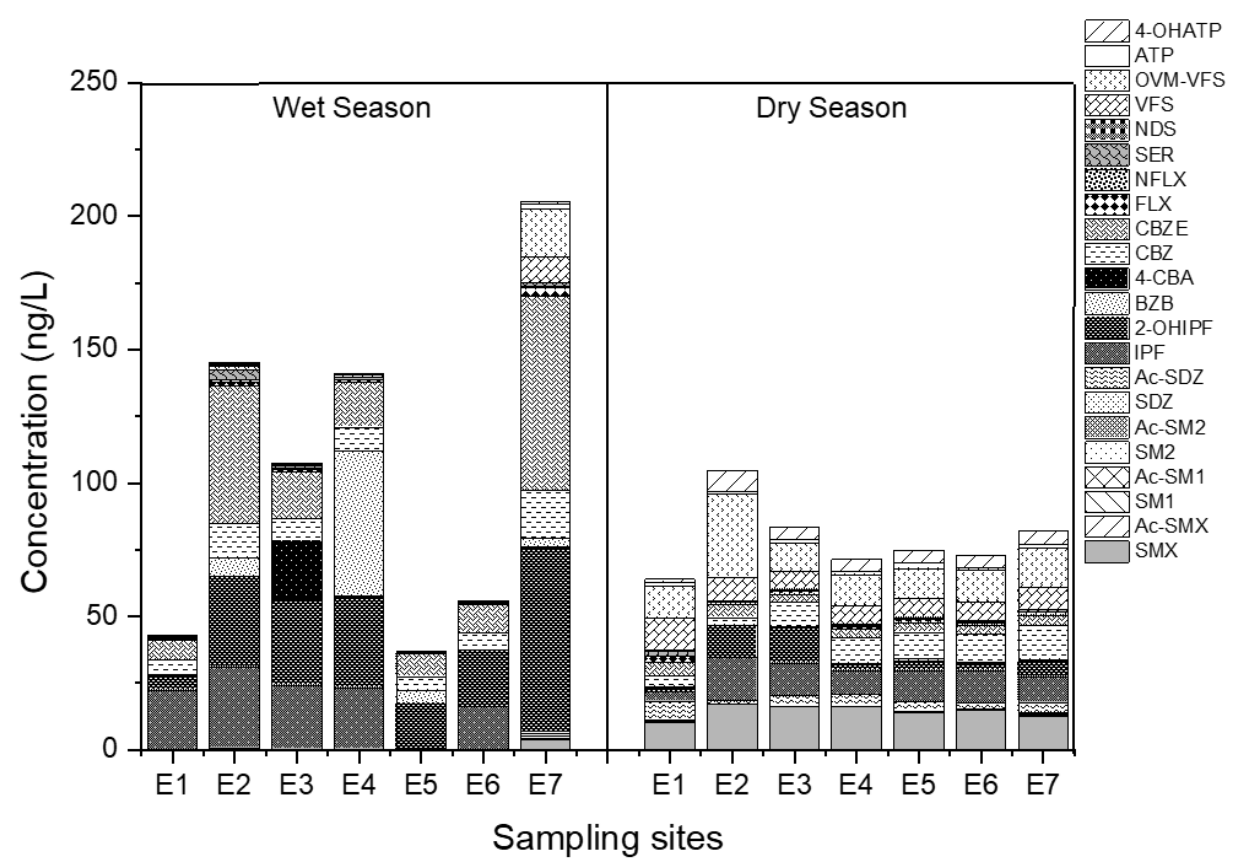
Figure 4. The spatial distribution of pharmaceutical metabolites and their parents in the water of the Yunliang river in different seasons.